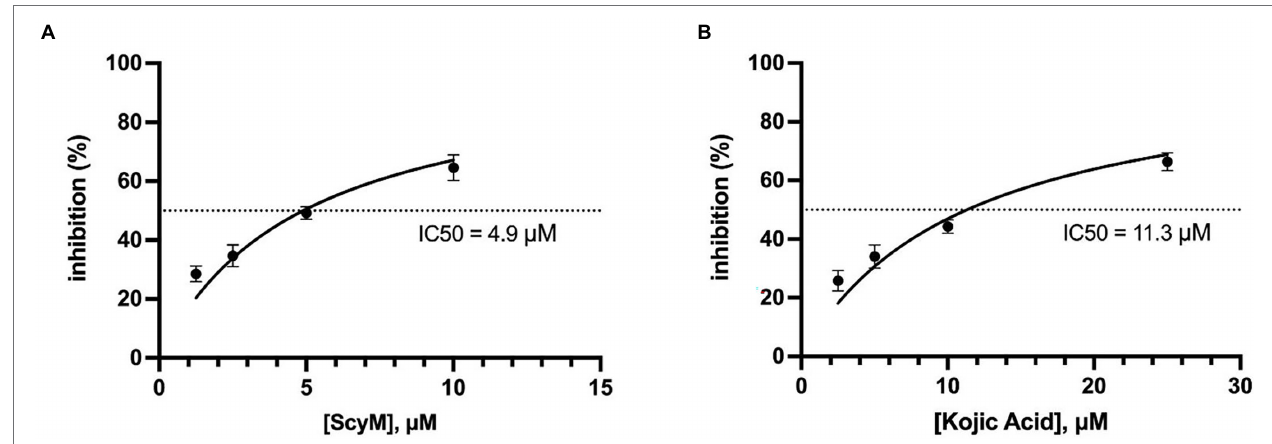
FIGURE 5 | Calculated curves of tyrosinase inhibitory effect versus inhibitor concentration. (A) Scytonemin monomer (ScyM, 1 ); (B) kojic acid (KA, 3 ). The dotted lines represent the IC 50 values, which were 4.9 μ M for ScyM and 11.3 μ M for KA, respectively. Experiments were carried in triplicate and error bars represent standard